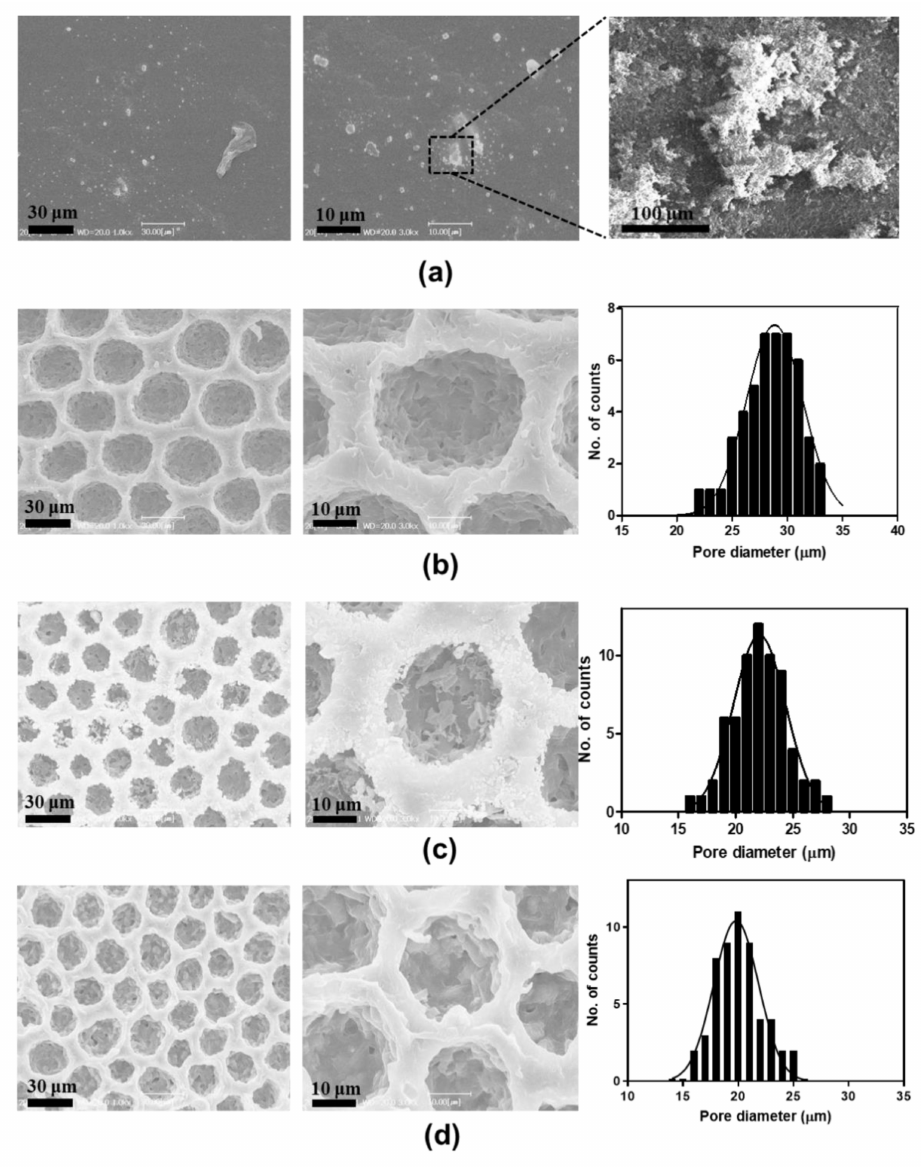
Figure 2. SEM images of ( a ) f-PANI, ( b ) PCL, ( c ) HCP-PANI, and ( d ) HCP-SPANI films. There was no significant difference in the HCP pattern of the HCP films, but a difference in morphology of PANI was observed functionalized on different films, such as flat, HCP, and sulfonated